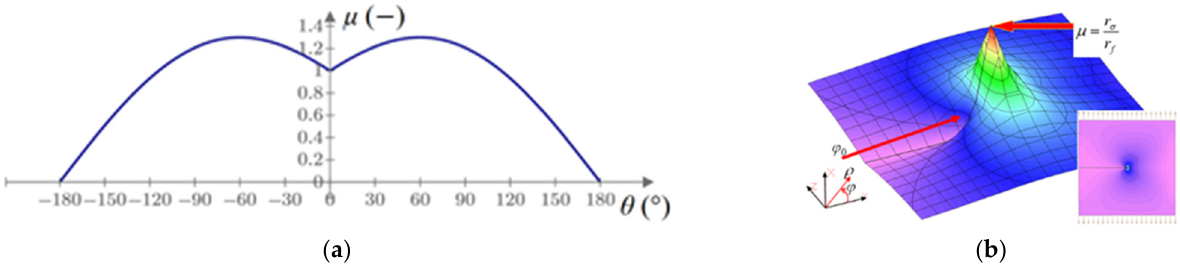
Figure 6. The material effort μ around the crack tip: ( a ) graph of μ for a unit radius; ( b ) three-dimensional graph of μ around the crack tip.